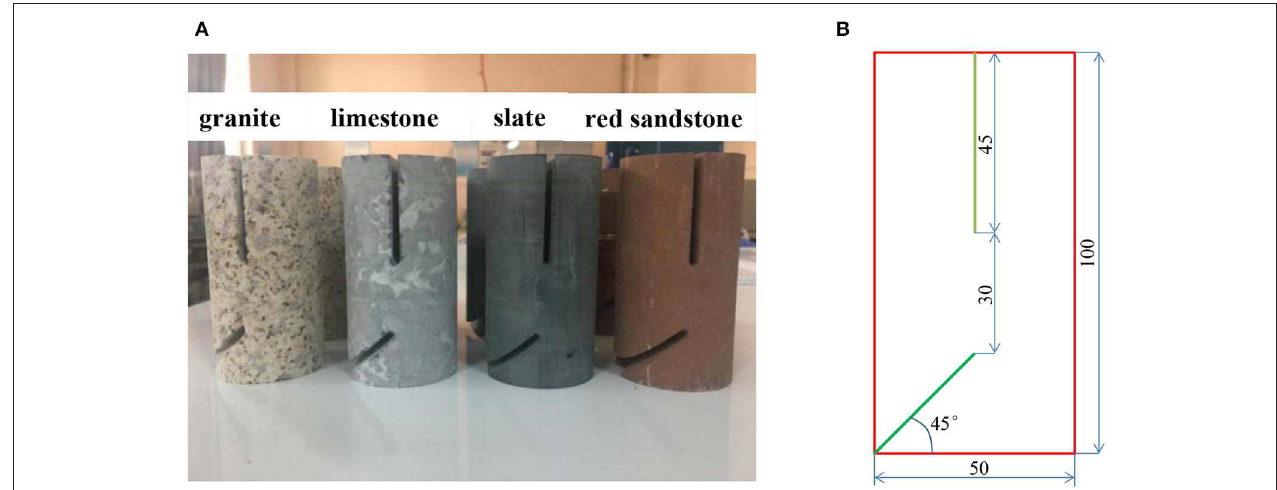
FIGURE 2 | Cracked rock specimen preparation. (A) Cracked rock specimen. (B) Cracked specimen